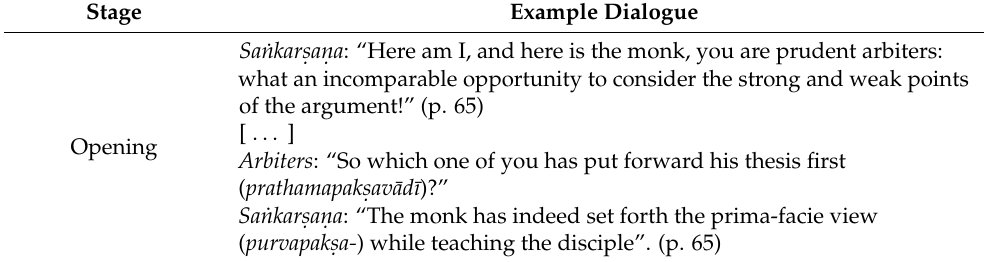
Table 4. Opening in Act